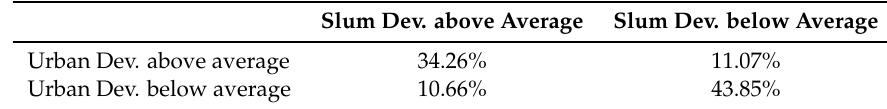
Table 7. Comparison of slum and urban development for a timestep of 5